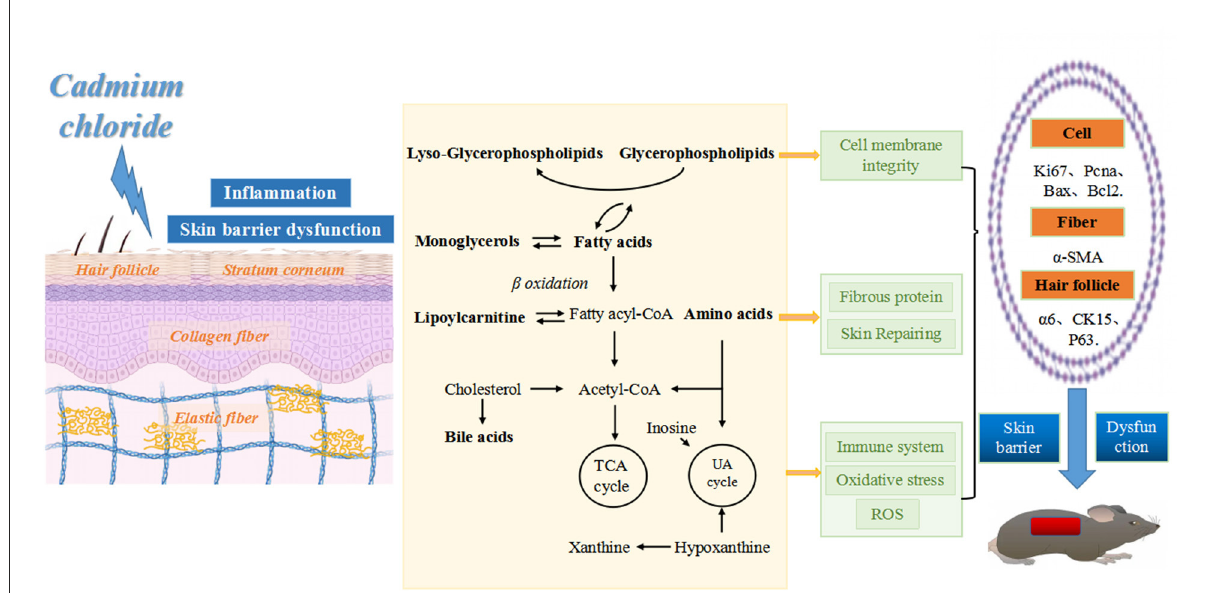
FIGURE9 Schematic diagram of skin tissue damage caused by CdCl 2 gavage. From left to right: CdCl 2 enters the body and acts on all layers of skin tissue, inducing inflammation and impairment of skin barrier function. This action may occur through the following pathways: (1) affecting the balance of phospholipid metabolism, disrupting the integrity of cell membranes and promoting the inflammatory process, leading to inhibition of cell proliferation (reduced Ki67 and Pcna expression) and accelerated apoptosis (increased Bax expression and reduced Bcl2 expression). (2) Affects amino acid metabolic balance, disrupts collagen fibers (decreased α -SMA expression) and skin repair functions. (3) Affects the metabolic balance of fatty acids, amino acids, bile acids and purines, leading to disruption of energy metabolism, increased oxidative stress, impaired skin immune function and destruction of hair follicle structure (decreased expression of α 6, CK15, and